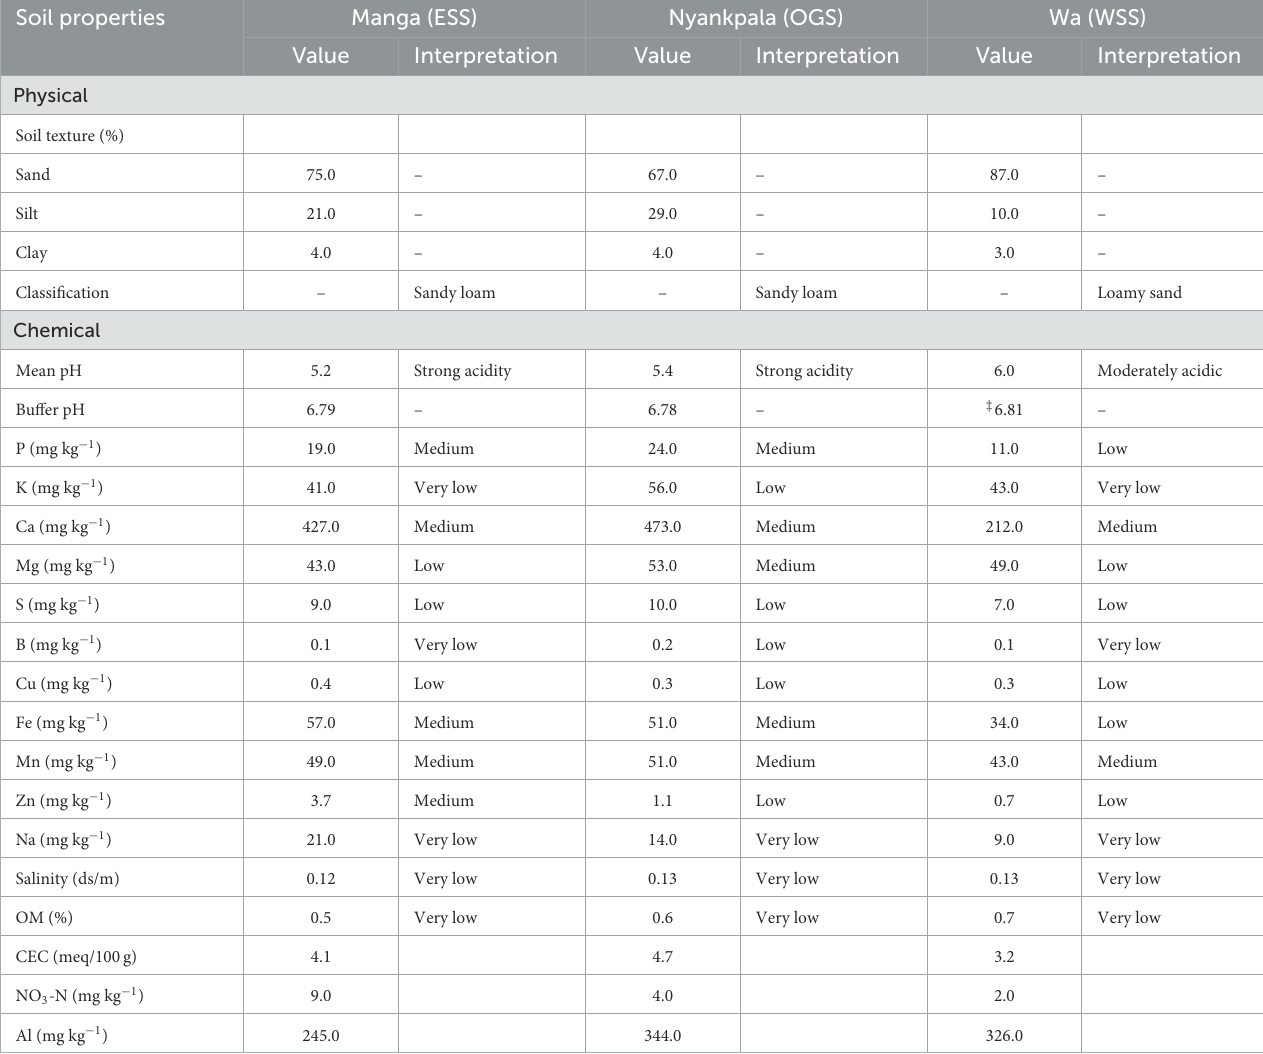
TABLE 4 Soil properties and fertility status at 0–15 (cm) soil depth for Manga, Nyankpala, and Wa in Ghana’s northern savannas across a 3-year average (2017–2019). Soil